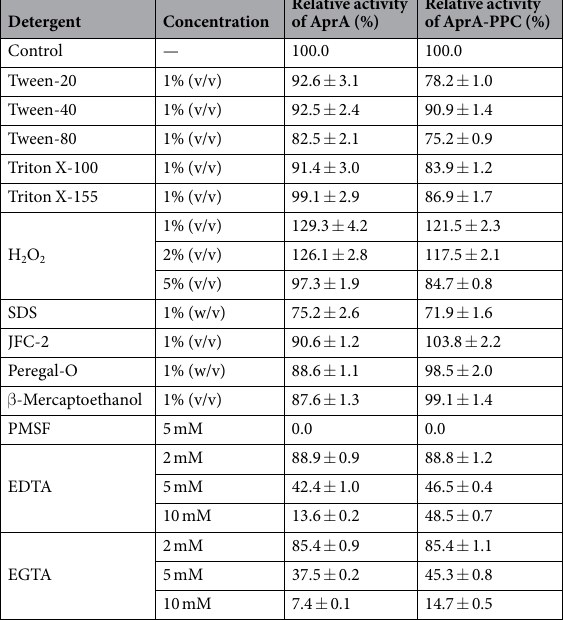
AprA AprA-PPC Substrate